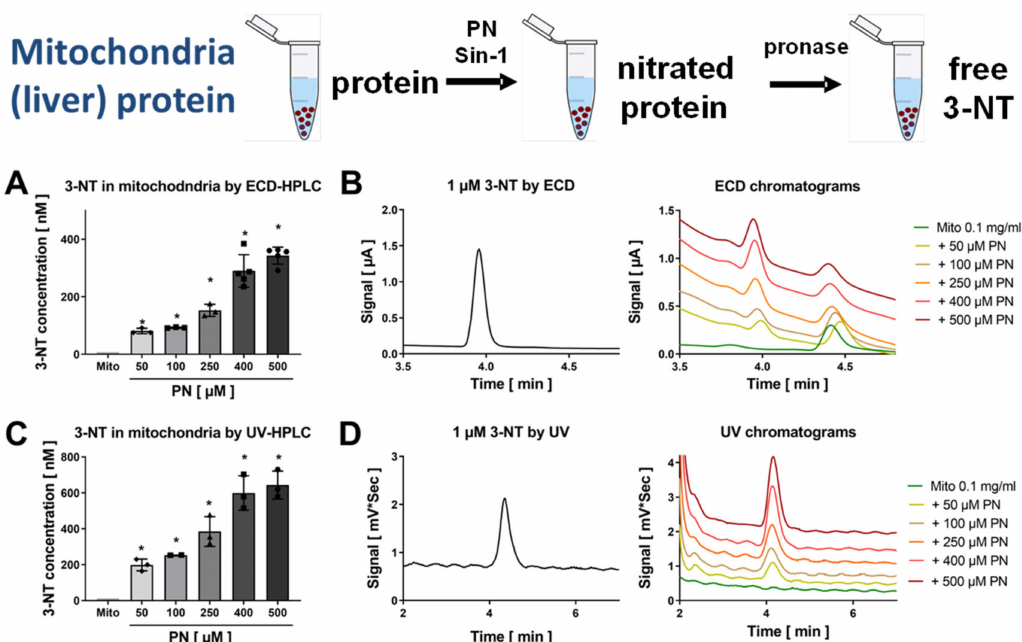
Figure 5. Detection of free 3-NT from nitrated liver mitochondria by HPLC / ECD or HPLC / UV. Isolated liver mitochondria were nitrated by PN (50–500 µ M). These samples were subjected to pronase digest before HPLC / ECD analysis ( A ) or HPLC / UV analysis ( C ). Representative chromatograms are shown for the HPLC / ECD quantification ( B ) or the HPLC / UV quantification ( D ). HPLC / ECD analysis was performed with 20 µ L of sample at 27 ◦ C with isocratic elution (1 mL / min, mobile phase: 26.3 mM sodium citrate and 10.9 mM sodium at pH 3.75 with 3.5 v / v % methanol; 3-NT eluted at 4.05 min). Data are presented as mean ± SD of n = 3–5 ( A ) and 3–5 ( C ) independent experiments. * indicates p < 0.05 versus Mito untreated control